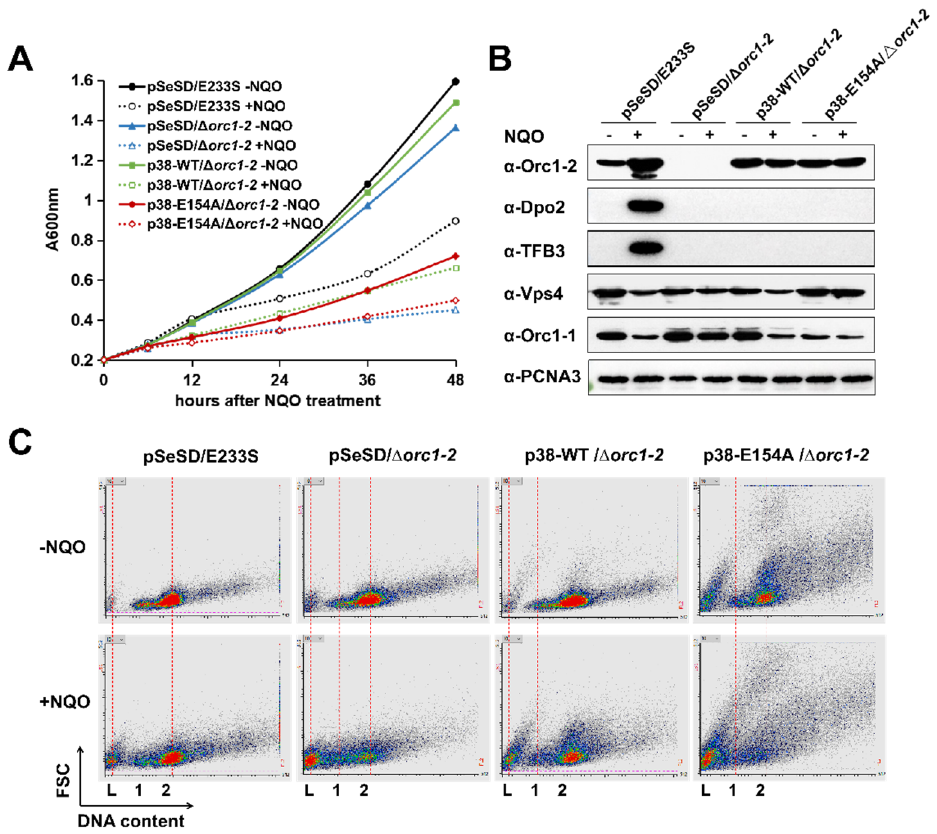
Figure 4. Expression of Orc1-2 E154A in S. islandicus . ( A ) Overexpression of Orc1-2E154A causes growth retardation in an NQO-independent manner. Saccharolobus cells were grown in ACV medium with or without 2 µ M NQO (indicated as +NQO and − NQO, respectively). Cultures were incubated for 48 h, during which cell samples were taken for monitoring their A600 values. ( B ) The expression level of selected DDR proteins in each strain. Exponentially growing cultures (OD 600 = 0.2) were treated by 2 µ M NQO for 12 h, and 10 µ g of total cell extracts of each sample was used for Western blot analysis. PCNA3 was used as the loading control protein. ( C ) Expression of Orc1-2E154A facilitates cell death. Flow cytometry profile of cell samples taken after 24 h NQO exposure. The results were shown in FL2 (DNA content, horizontal axis)-FSC (Forward scattered light, vertical axis) cytograms. Both axes are shown in liner scale. L: DNA-less cells; 1: cell population containing one chromosome; 2: cells containing two